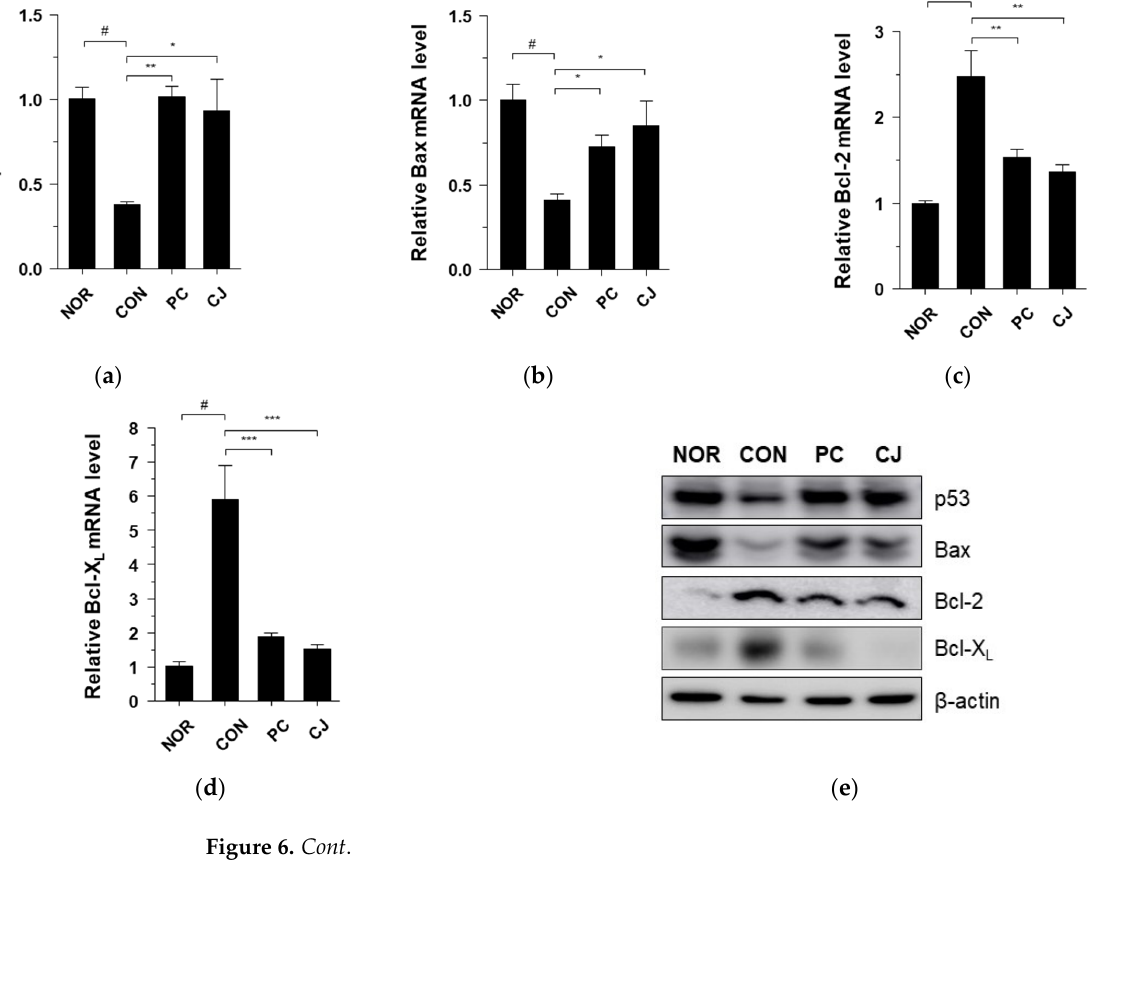
9 of 12 Figure 5. Effects of CJ on the expression of mucin-associated protein and tight junction proteins in mice with AOM/DSS-induced CAC. Shown are the mRNA levels of ( a ) Muc2, ( b ) occludin, and ( c )